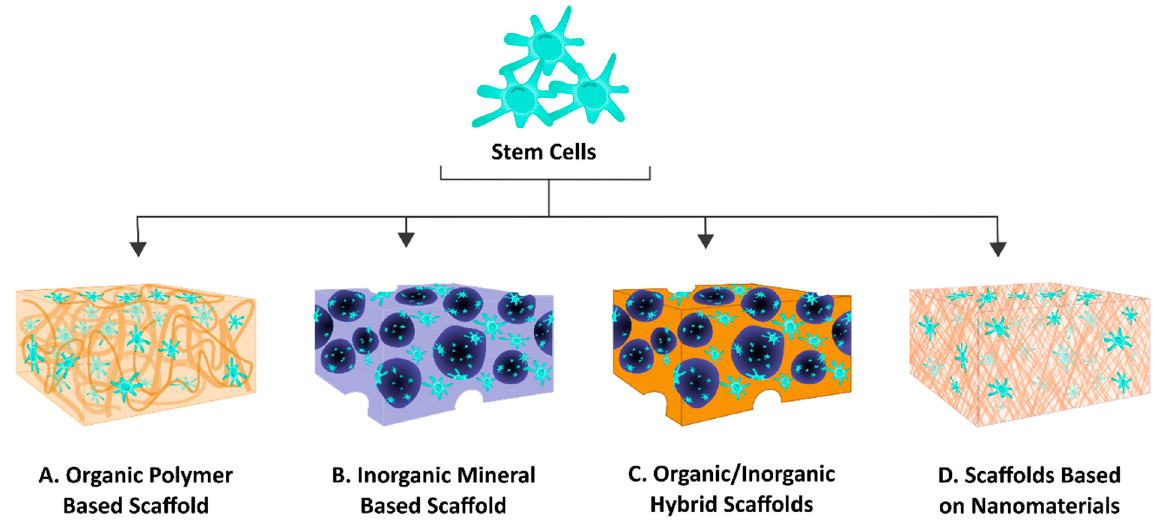
Figure 5. Scaffold types used for stem cell-based tissue engineering approaches: ( A ) Organic polymer-based scaffolds; ( B ) Inorganic mineral-based scaffolds; ( C ) Organic/inorganic hybrid scaffolds consisting of polymer and mineral components; ( D ) Scaffolds based on nanomaterials.